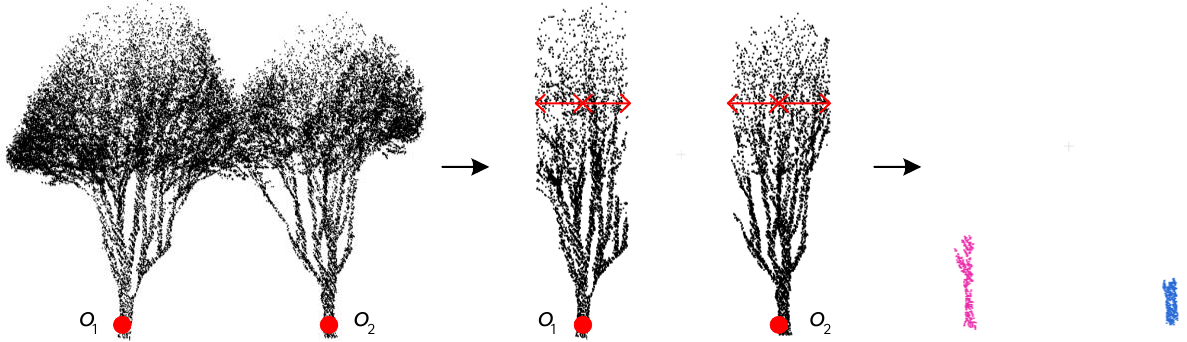
Figure 3. Process of trunk extraction.